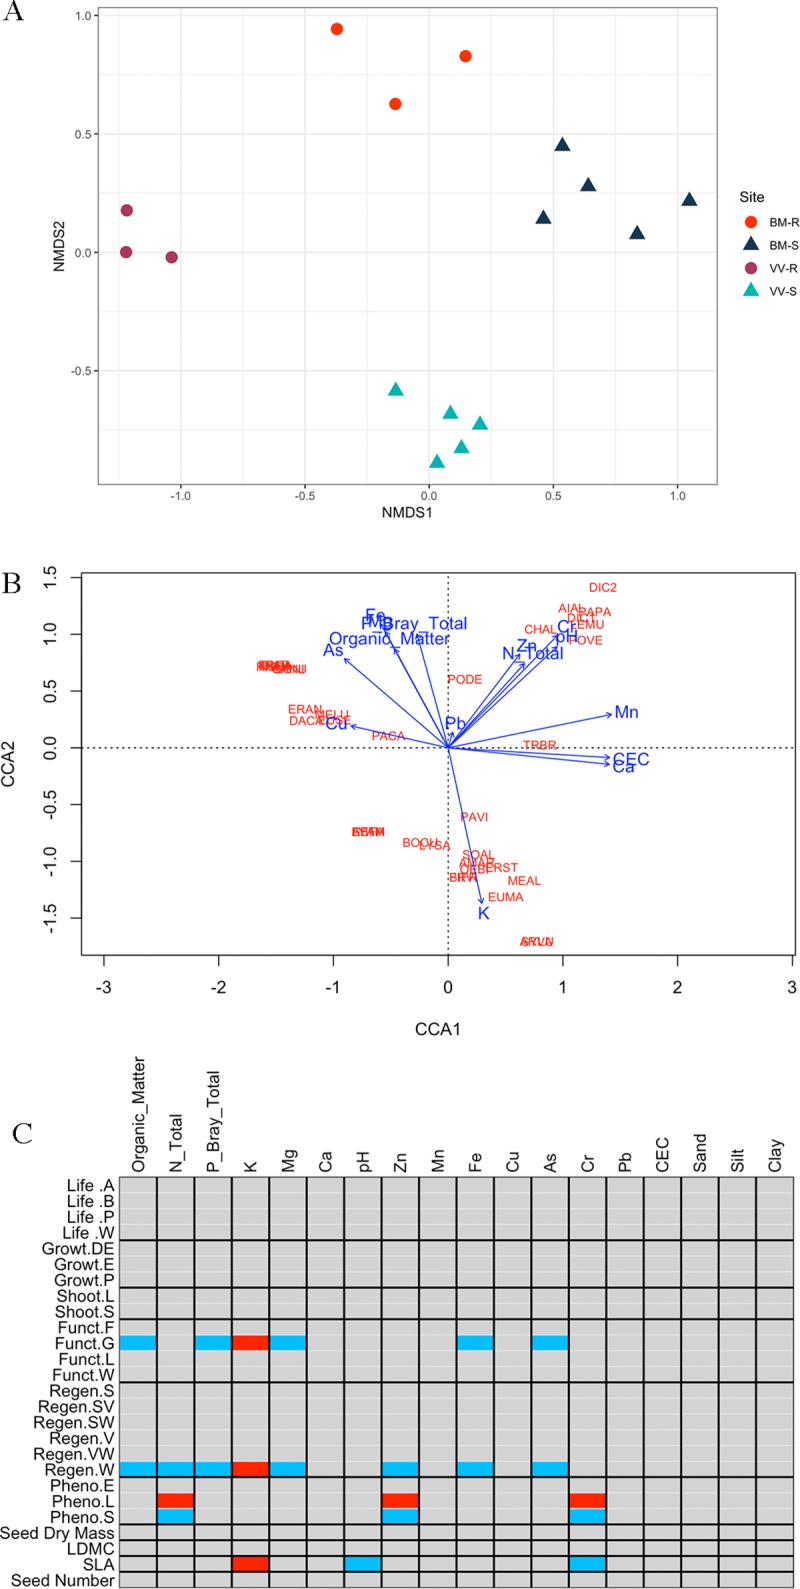
Community structure of removal plots.(A) NMDS results of site difference based on species presence-absence. Slag plots are in triangles, Reference plots in circles. See Table H in S1 File for associated statistical analyses, and Fig D in S1 File for inclusion of species in the NMDS space. (B) CCA result showing association between species and environmental variables. (C) Fourth-corner analysis of RLQ model showing association between functional traits and environmental variables; significant associations are colored, with positive as red and negative as blue. See S3 File for a complete list of species abbreviations; see S4 File for complete functional trait data with abbreviations.